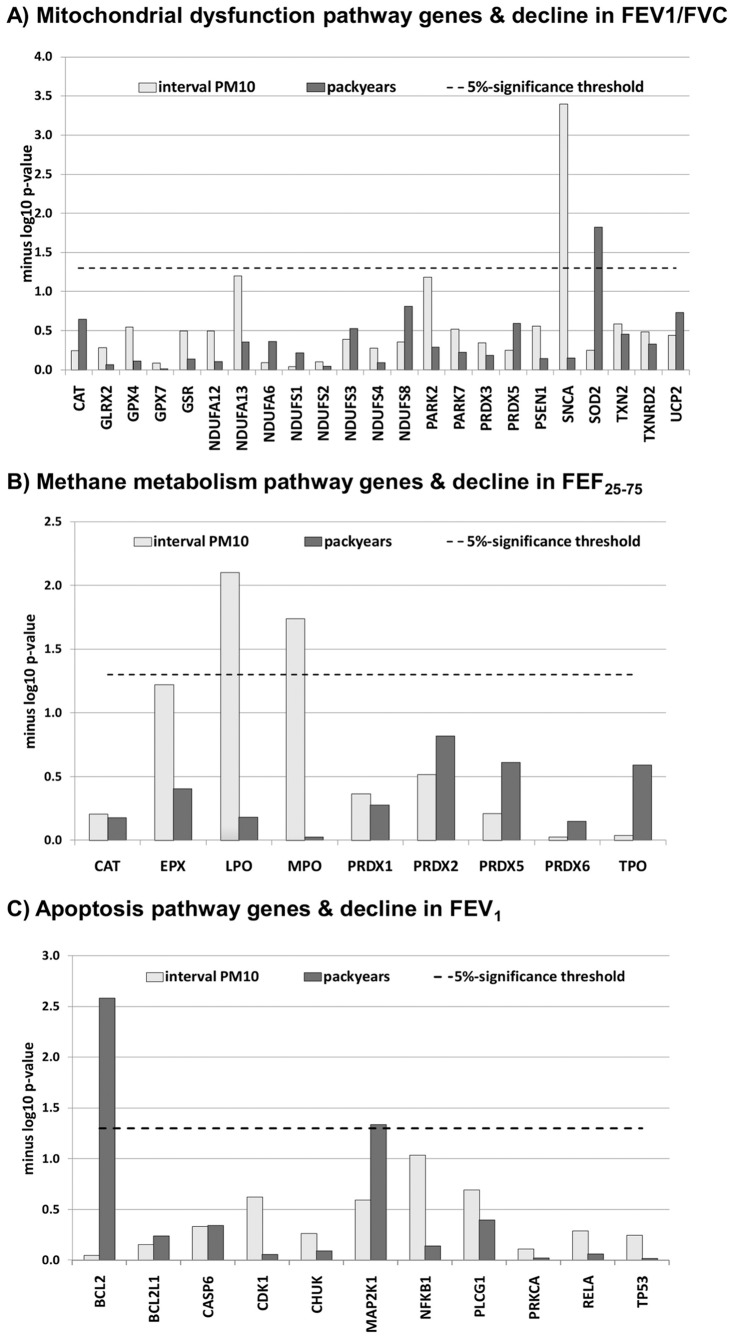
Distribution of interaction p-values across genes mapping to pathways with weak interaction signals.P-values of interaction on the gene-level are given on a minus log10 scale (y-axis), i.e. higher bars represent smaller interaction p-values. (A) Genes of the mitochondrial dysfunction pathway interacting with PM10 and packyears exposure between surveys on FEV1/FVC decline. (B) Genes of the methane metabolism pathway interacting with PM10 and packyears exposure between surveys on FEF25–75 decline. (C) Genes of the apoptosis signaling pathway interacting with PM10 and packyears exposure between surveys on FEV1 decline.